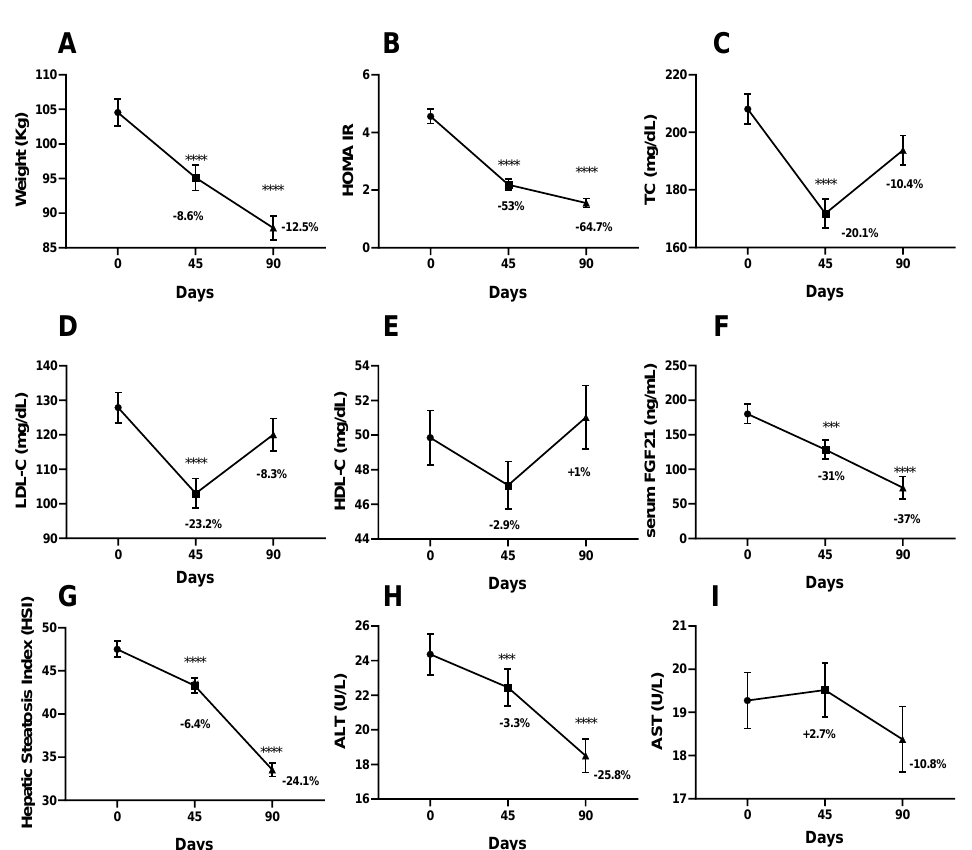
Figure 1. E ff ect of dietary intervention involving a first VLCKD phase (from T0 to T45) and a second LCD phase (from T45 to T90) on ( A ) weight, ( B ) HOMA-IR, ( C ) TC, ( D ) LDL-C, ( E ) HDL-C, ( F ) FGF21 serum level, ( G ) HSI, ( H ) ALT, ( I ) AST. Data show percentile changes of the variable from T0 to T45 and from T0 to T90. Asterisk (*) denotes statistically significant changes from T0 to T45 and from T0 to T90 at the 0.0001 (***), < 0.0001 (****) level. Abbreviations: HOMA-IR, homeostasis model assessment; FGF21, fibroblast growth factor 21; HSI, hepatic steatosis index; AST, aspartate transaminase; ALT,